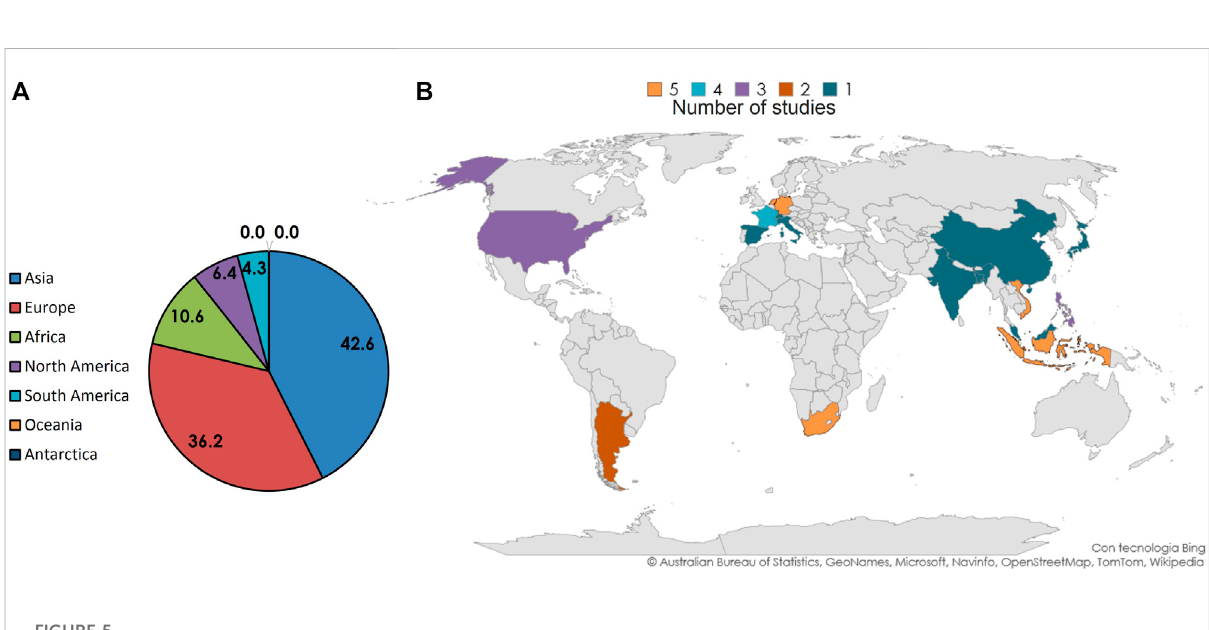
FIGURE 5 (A) Frequency of studies on macroplastics in rivers (%) conducted in each continent. (B) Global distribution of macroplastics (i.e., number of studies)inriverscarriedoutineachcountry.Notethat globalriverine plastichotspotareasmainlyfocusedonAsiaandEurope.Images obtained with Excel and Bing